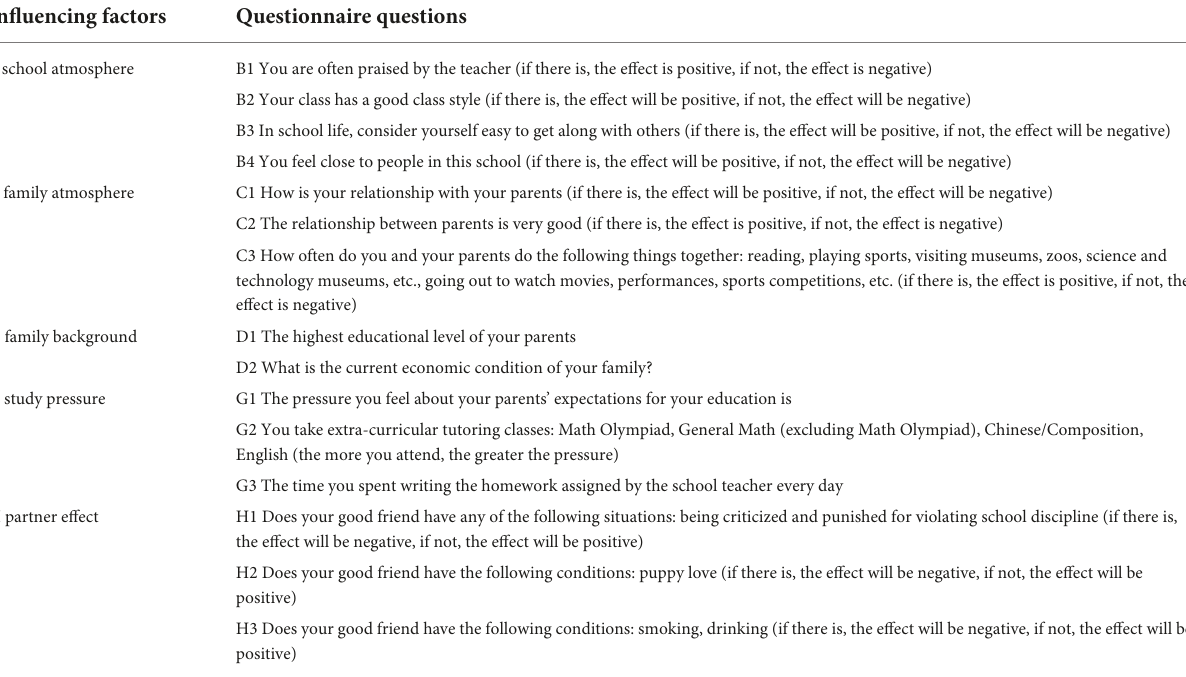
FIGURE3 Standards for mental health of adolescents.